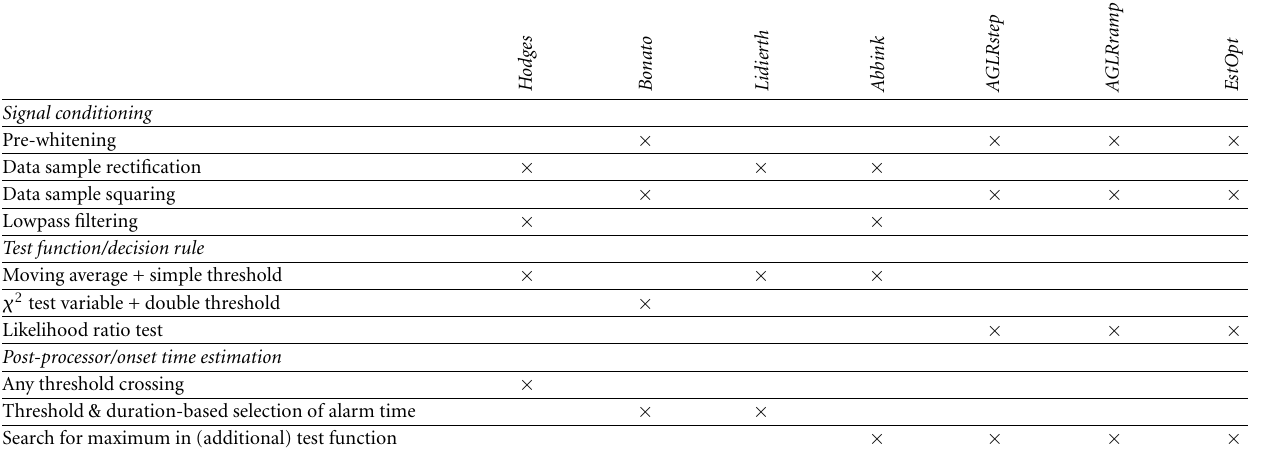
Table 1: Characteristic properties of all examined onset detection